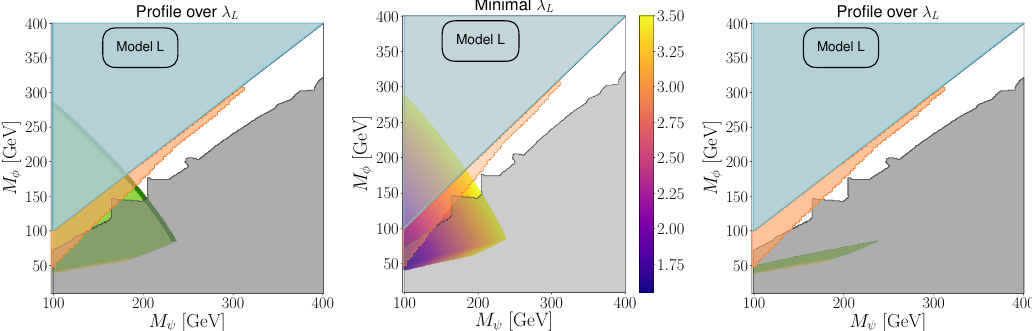
Figure 6. Several profiles of Model L. Colours for the first and third panels are the same as figure 5, and the same LHC limits (which do not depend on the coupling) are overlaid. The left panel shows the best contributions to a for each value of the BSM masses, without having a dark µ matter candidate particle with an over abundant relic density. Likewise, the right panel only shows points which have a dark matter relic density within 1 σ of the Planck observation [416]. The middle panel shows the smallest value of the coupling λ which can explain a 2021 (eq. (1.7)) within 1 σ L µ without producing over abundant dark